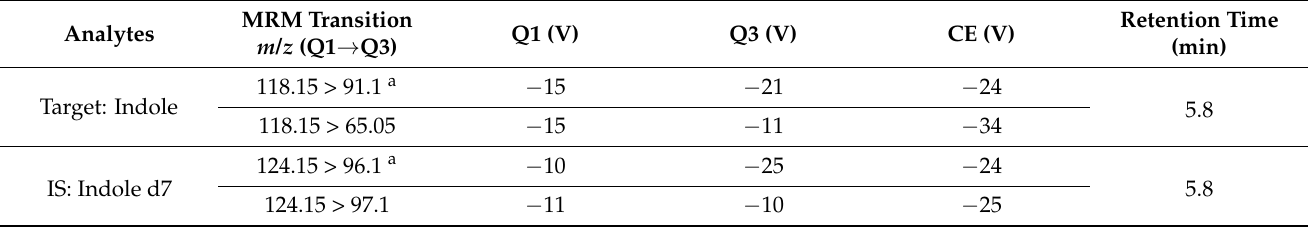
Table 1. Summary of MS/MS parameters: precursor ion, fragment ions, voltage potential (Q1), collision energy (CE) and voltage potential (Q3) for indole and indole d7